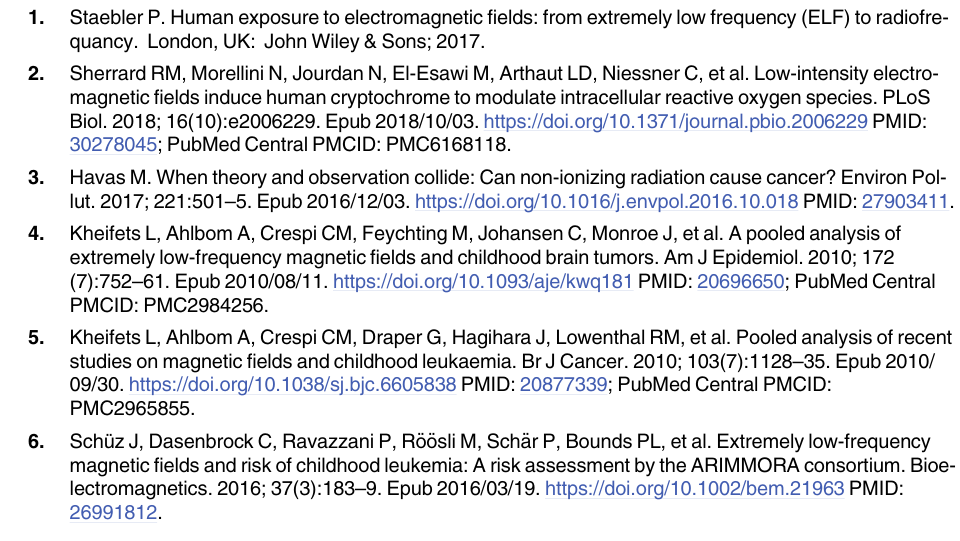
S1 Table. Search strategy in databases. Search strategies and search results for each database (Pubmed, Embase, Web of